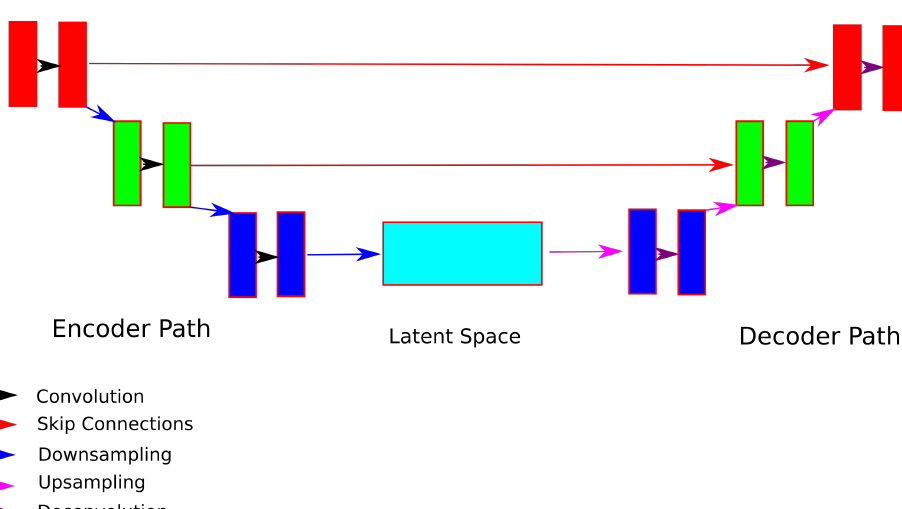
Figure 1. The schematic diagram of a U-Net architecture. The model is divided into a contraction path and an expansion path, with the latent space representation generated at the end of the contraction path. The contraction is comprised of a convolution with a set of filters, followed by a downsampling operation that reduces the size of the image. This process is continued until the latent space is reached. In the expanding path, there is an upsampling followed by a deconvolution. This process is continued until the desired output image is reached. The corresponding layers of the expansion and contraction paths are connected using so-called skip connections.